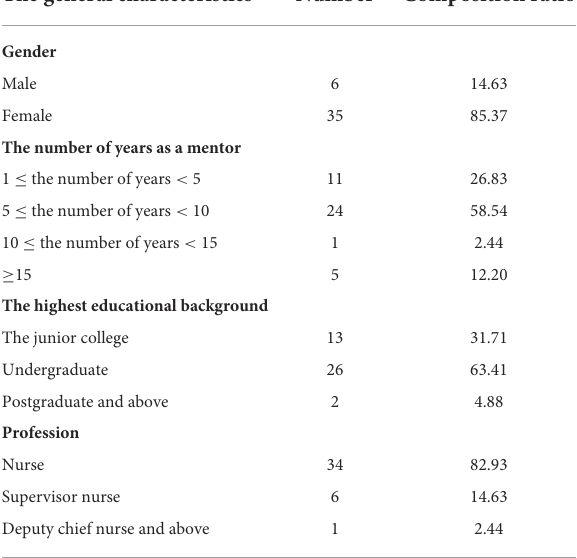
TABLE 1 The general characteristics of the mentors.